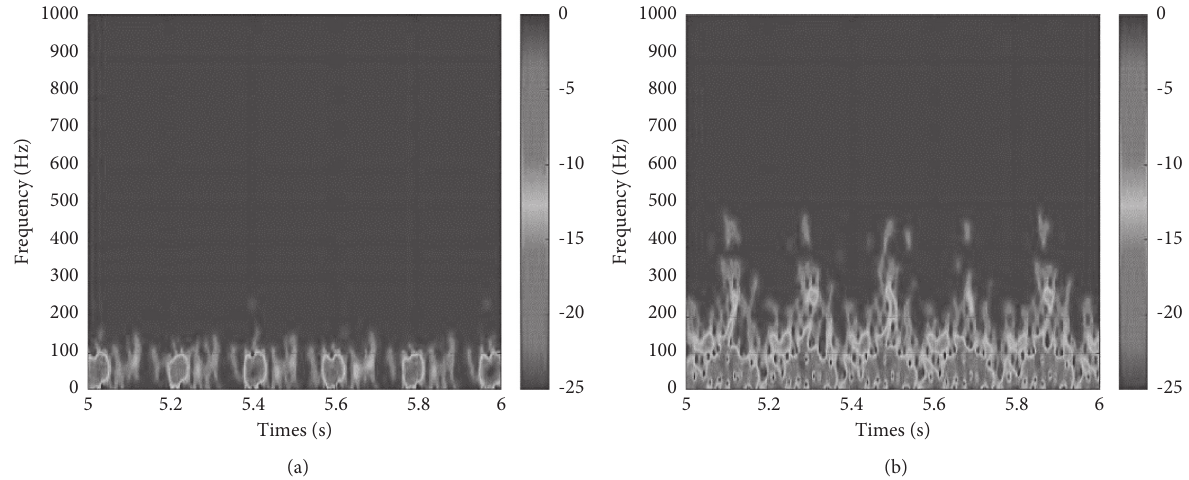
Figure 11: Vibration time-frequency of the pressure plate and hook-driven shaft. (a) Time-frequency of the pressure plate. (b) Time- frequency of the hook-driven shaft.